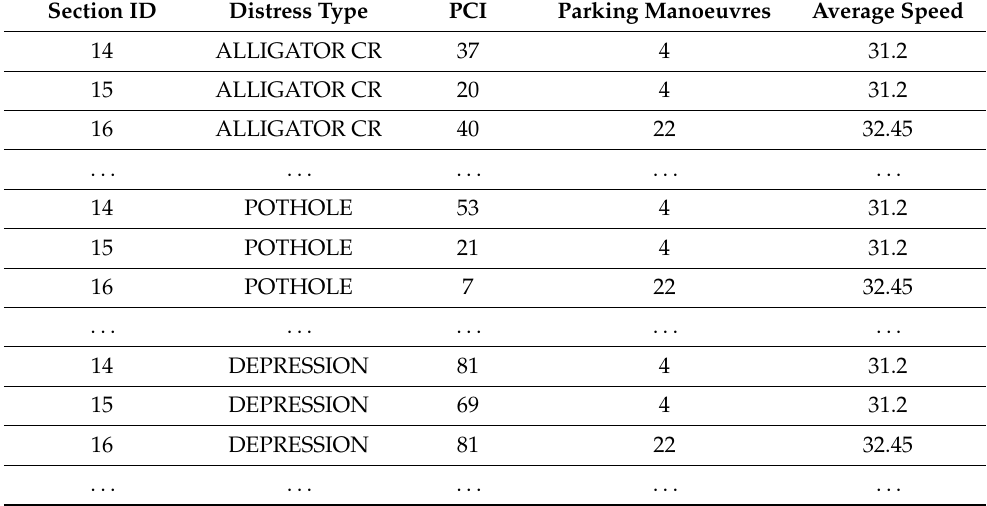
Table 2. Sample of the data prepared for multilevel modelling.